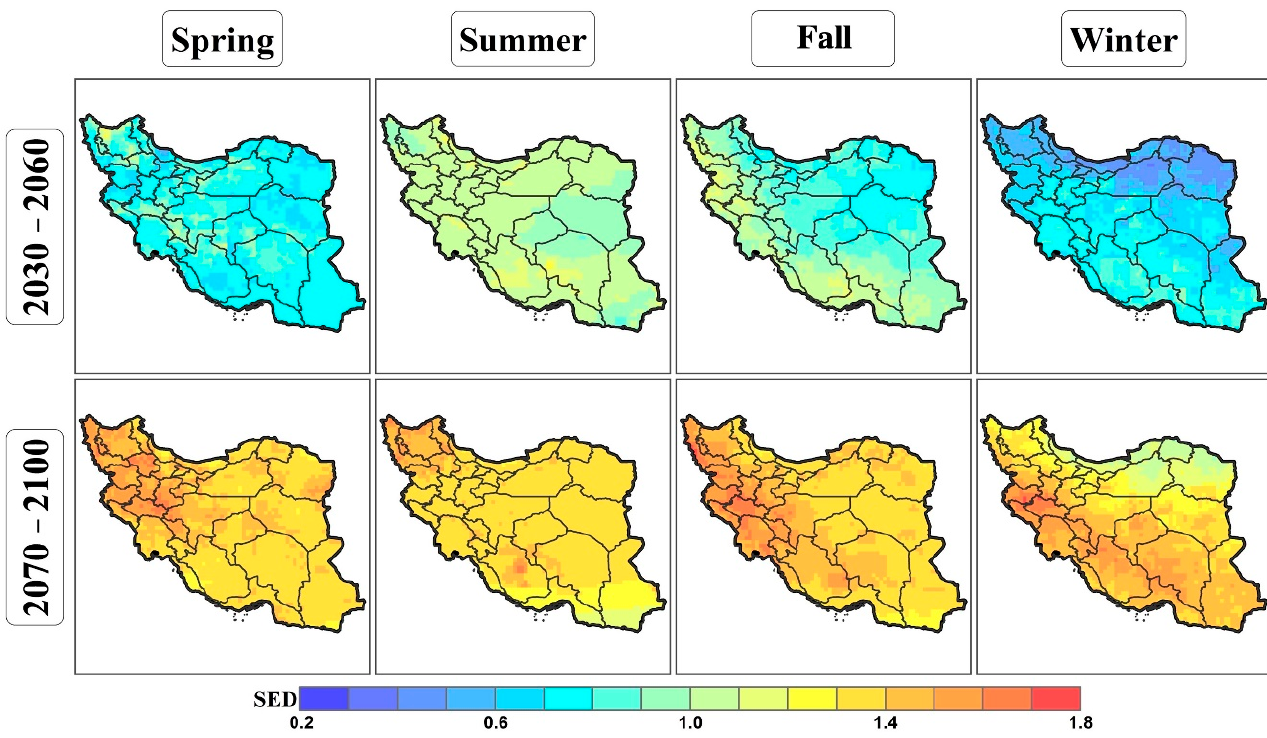
Figure 4. SED scores over the study area during the 2030–2060 and 2070–2100 periods for RCP8.5 during different seasons. Unitless.